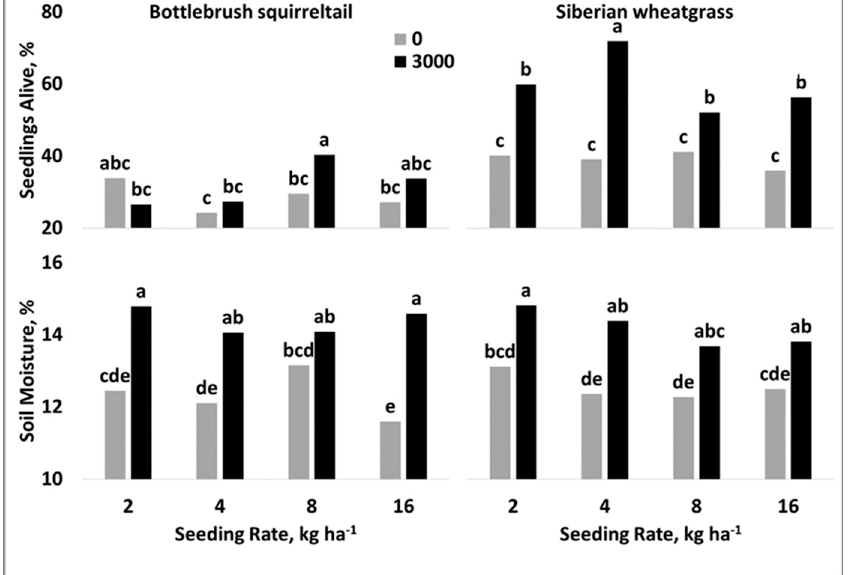
Figure 5. Percentage of live seedlings ( p < 0.0001) and percent soil moisture ( p = 0.0218) as a function of seeding rate and superabsorbent polymer (SAP) application averaged across 56 d of a glasshouse study for bottlebrush squirreltail (on the left) and Siberian wheatgrass (on the right). The SAP rate of 3000 kg ha − 1 was placed in a band at a depth of 8 cm directly below the seed. Following SAP treatment, the soil was saturated once and then dried down naturally over the time of the study. Bars within a species for each variable that share the same letter are not statistically different from each other.